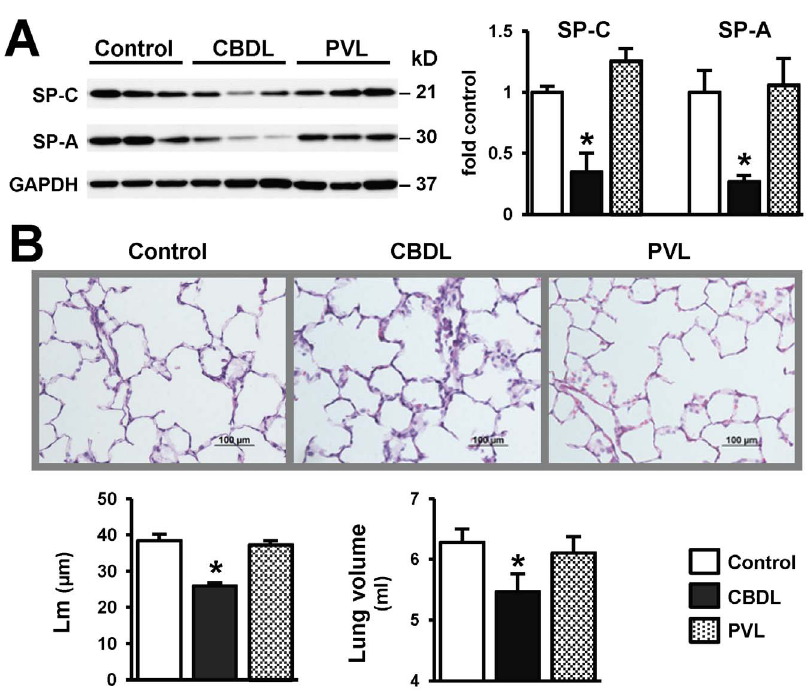
Figure 2. Comparison of pulmonary associated protein (SP) levels and morphologic changes in CBDL and PVL animals. ( A ) Representative immunoblots and graphical summaries of protein levels of SP-A, SP-C (precursor) and GAPDH in lung from 3-week CBDL and 3-week PVL animals. Three independent experiments were performed. SPs protein levels were normalized to the levels of GAPDH. Significant decreases in lung SP-A and SP-C levels were only seen after CBDL, not PVL. ( B ) Representative H&E images of animal lung and quantitation of alveolar mean cord length (Lm) and right lung volumes by saline displacement method. Six animals were used in each group. Ten to fifteen fields were counted per tissue section. The analysis was performed in a blinded manner. Relative to control or PVL, CBDL resulted in shrunk alveoli. There was a significant reduction in Lm and lung volumes in 3-week CBDL animal, which was not seen in control or 3-week PVL. Scale bar 5 100 m m. Values are expressed as means ¡ SME. * P , 0.05 compared with